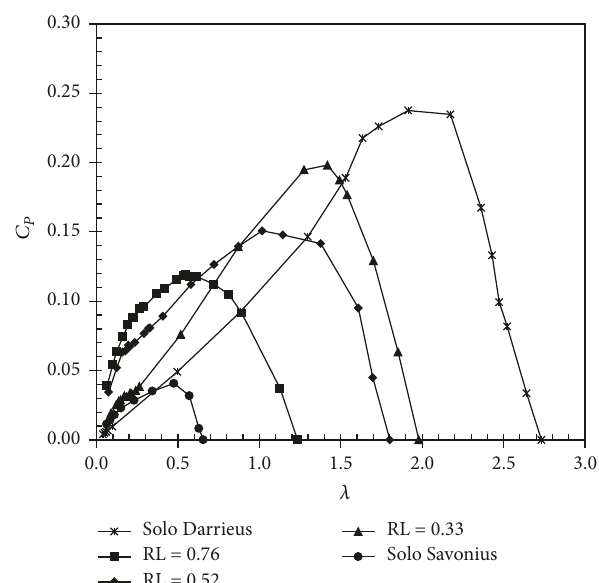
Figure 5: Coefficient of power (case